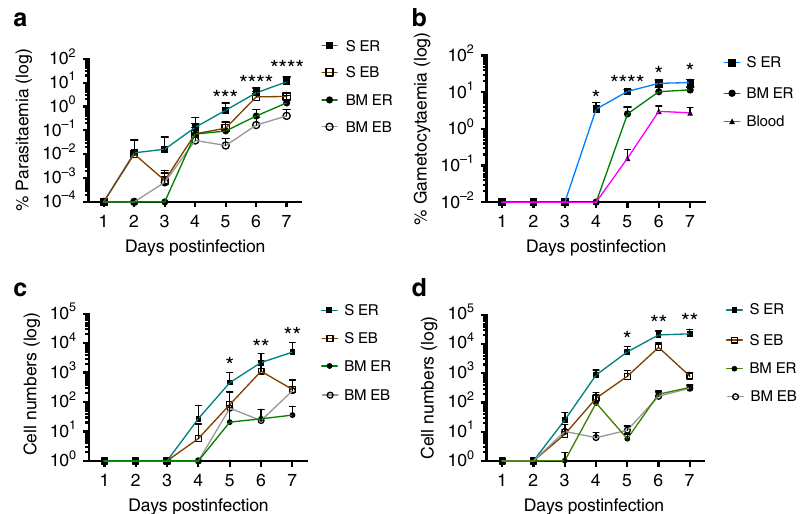
Fig. 3 P. berghei gametocytes are preferentially formed within splenic early reticulocytes. Samples were taken every 24 h across an acute P. berghei PbGFP CON /RFP GAM infection and quanti fi cation of gametocytes within tissue resident erythroid cells performed by FACS. a The splenic ER of BALB/c mice have a higher parasitemia compared with all other tissue resident erythroid cells day 5 pi. Error bars ± SEM. b The gametocytemia of the splenic ER is signi fi cantly greater than peripheral blood from day 5 pi. Error bars ± SEM. The asterisks display refer to the comparison between splenic ER and peripheral blood. c Signi fi cantly greater numbers of gametocytes were observed in splenic ER from day 5 pi compared to all other tissue resident erythroid populations in BALB/c mice. Error bars ± SEM. d The abundance of asexual parasites with splenic ERs was signi fi cant within BALB/c from day 5 pi. Error bars ± SEM. Signi fi cant differences mentioned above were assessed by one-way ANOVA alongside Dunnett ’ s multiple comparisons test and indicated with asterisks: * p < 0.05, ** p < 0.01, *** p < 0.001, **** p <